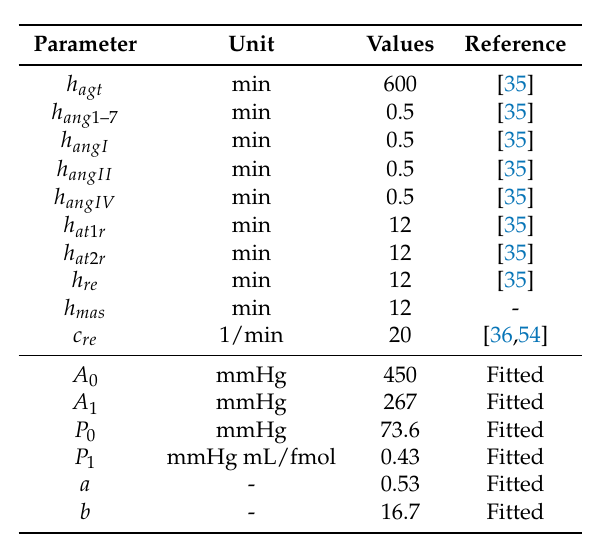
Table 1. Half-lives of the species involved in RAS and other parameters of the model. “Fitted” means fitted on experimental data.